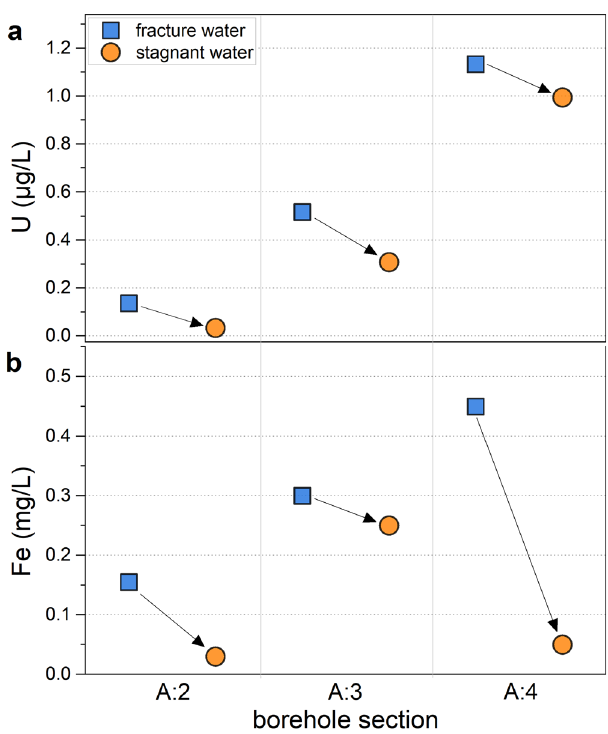
Fig. 3 Uranium and iron variation in waters. a U and b Fe concentration in fracture water (blue squares) vs stagnant water (orange circles) in monitored A:2, A:3, and A:4 sections in KA3105A borehole based on analysis of the fi nal water withdrawal (see Supplementary Table